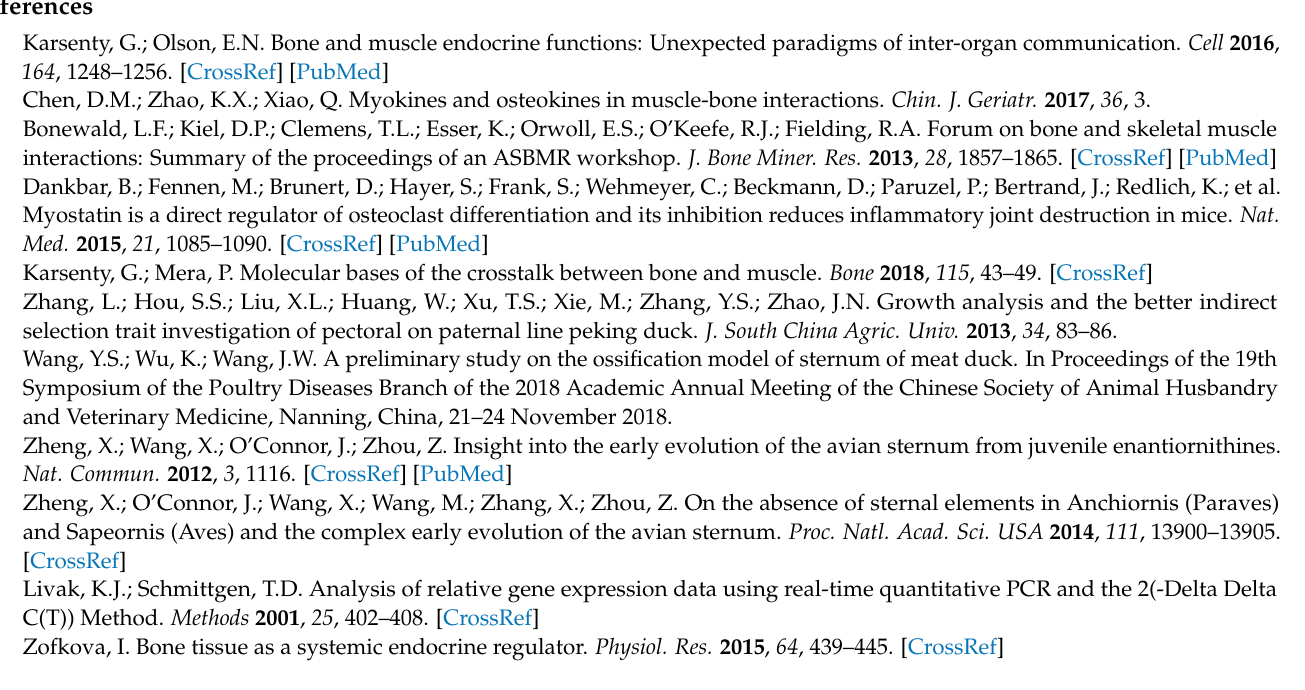
Supplementary Materials: The following are available online at https://www.mdpi.com/2073-442 5/12/4/463/s1, Figure S1: Top two modules from the PPI network in the calcified and un-calcified sternum; Figure S2: Validation of RNA-seq results by qRT-PCR. Correlation plots indicating the relationship between qRT-PCR results (fold change; Y-axis) of 6 selected genes and the corresponding data from RNA-seq analysis (X-axis); Figure S3: The PPI networks of DEGs, whereby red nodes represent DEGs in pectoral muscle and blue nodes represent proteins secreted by bone; Figure S4: The PPI networks of DEGs, whereby red nodes represent proteins secreted by pectoral muscle and blue nodes represent DEGs in bone; Table S1: Primers used in Real-time PCR; Table S2: Quality control of sequencing data; Table S3: Differentially expressed genes in sternum between the calcified and un-calcified groups; Table S4: The enriched pathways of modules; Table S5: List of cluster analysis between proteins secreted by sternum and DEGs in the pectoral muscle; Table S6: List of cluster analysis between proteins secreted by pectoral muscle and DEGs in the